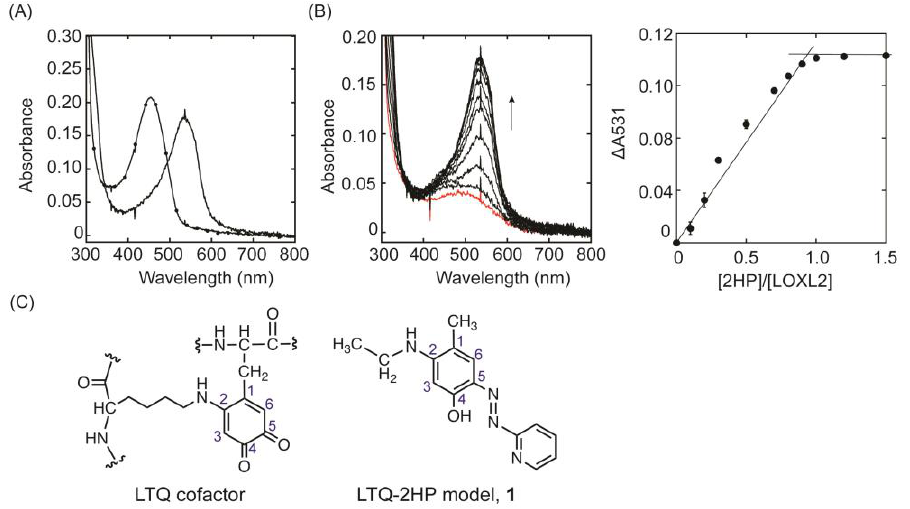
Figure 2. Inhibition of LOXL2 with 2HP. ( A ) UV-vis spectra of PH-inhibited LOXL2 (—-) and 2HP-inhibited LOXL2 ( −•− ). ( B ) UV-vis spectroscopic titration of LTQ with 2HP. Increase in absorbance at 531 nm was observed. The UV-vis spectrum of the resting LOXL2 (containing unmodified LTQ) before addition of 2-HP is shown in red (left). The absorbance change at 531 nm ( ∆ 531) was plotted against the molar ratio of [2HP]/[LOXL2]. The increase in absorption at 531 nm was saturated near [2HP]/[LOXL2] = 1.0 (right). The UV-vis spectroscopic titration was done in triplicate and the error bars were generated by Kaleidagraph. The spectral changes were linear up to [2HP]/[LOXL2] = 0.95 and reached a plateau at ≥ [2HP]/[LOXL2] = 1.0. ( C ) Structures of the LTQ cofactor (left) and LTQ-2HP model compound, 1 (right). A numbering system of carbons of the LTQ cofactor in the enzyme [4] is applied to the model compound, 1